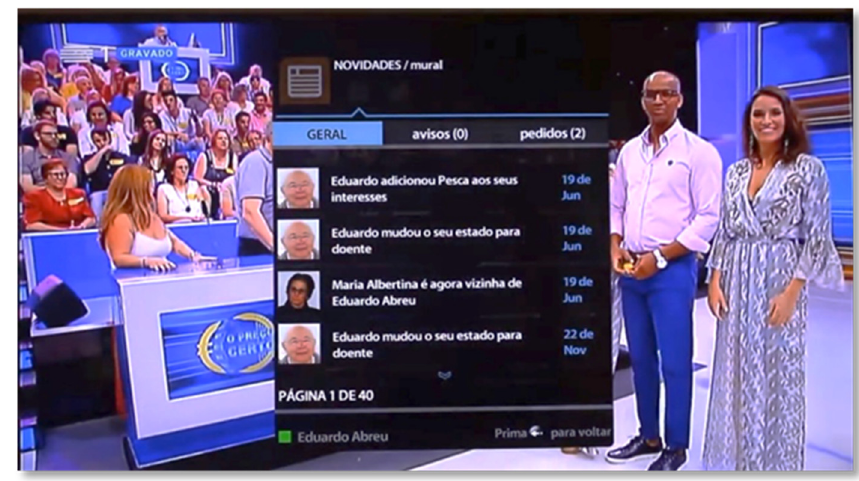
Figure 7. News area of the SecurHome TV application.